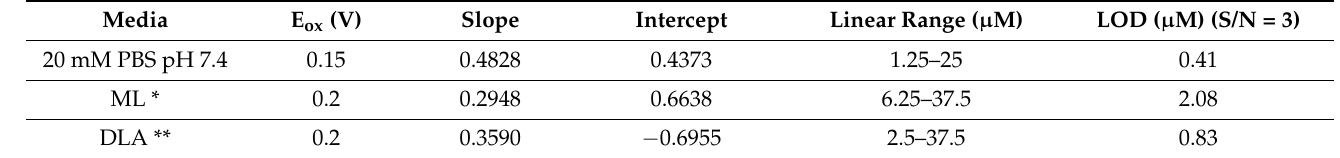
Table 2. Analytical parameters for Ent detection in 20 mM PBS pH 7.4 and in specific culture media.